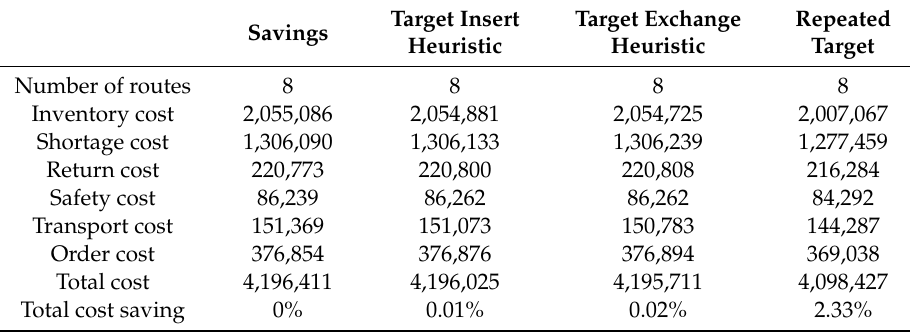
Table 5. The simulated numerical results for